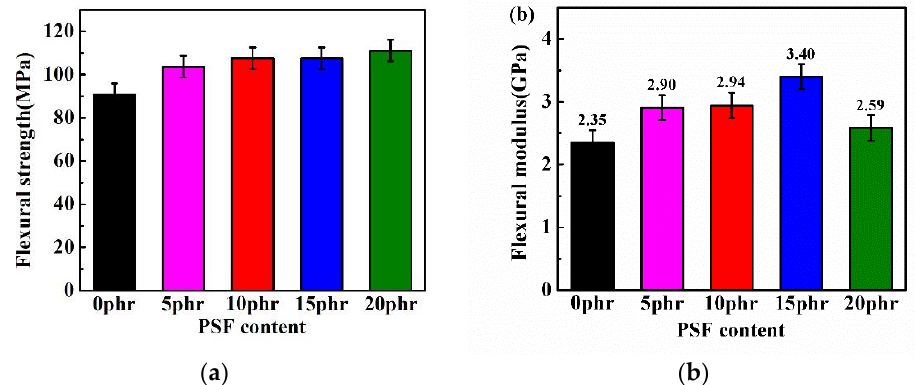
Figure 7. The flexural strength ( a ) and modulus ( b ) of PSF/epoxy blends as a function of PSF content.